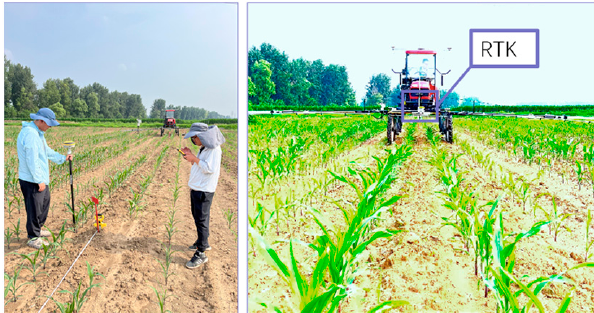
Figure 13. Field test layout.